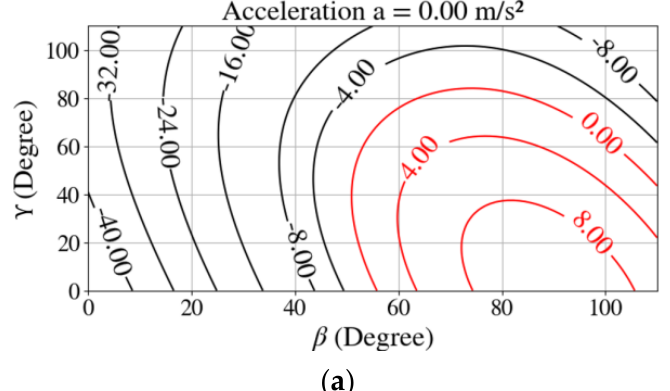
Figure 11. Free body diagram of mobile manipulator considering dynamic forces and moments gen- erated by operation movements.